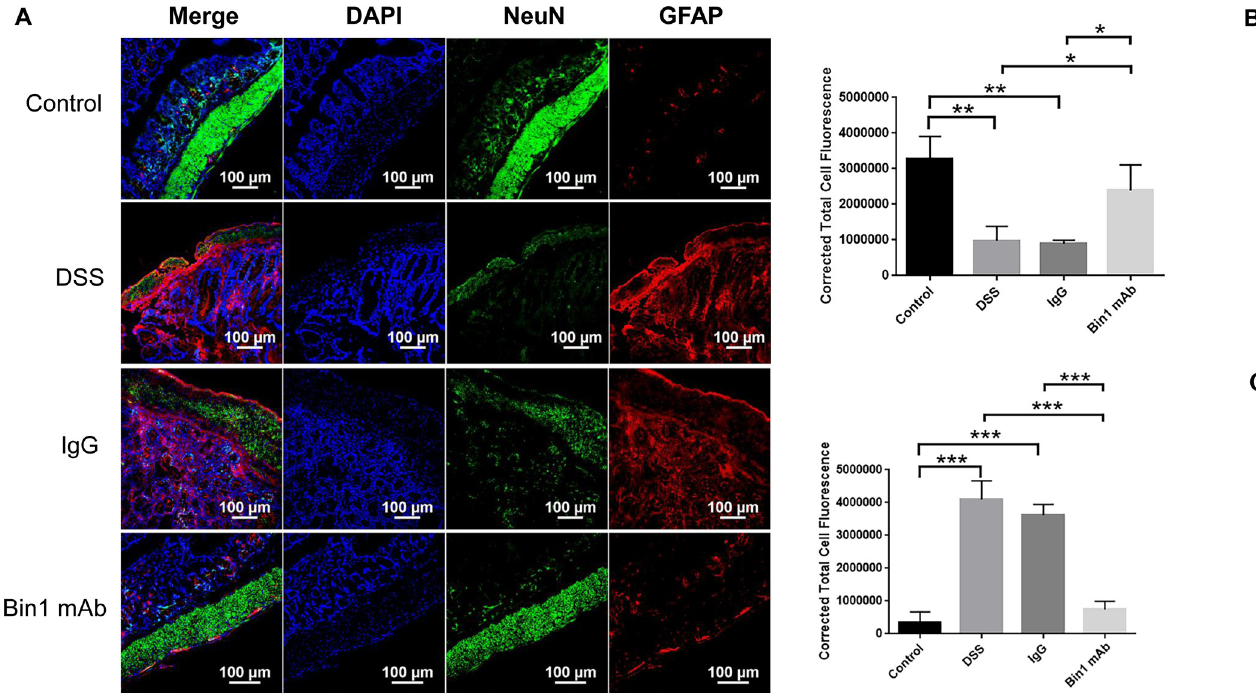
Fig 2. Bin1 mAb treatment improved NeuN expressing enteric neurons and GFAP expressing glial cells after DSS-induced colitis. Fig 2A . Effect of Bin1 mAb treatment on neuronal and glial abundance in the gut of DSS-induced colitis mice as determined by confocal microscopy. Bin1 mAb treated mice had high expression of NeuN and low expression of GFAP (n = 5). Fig 2B . Bin1 mAb treated mice had high levels of NeuN expressing neuronal cells in the muscularis of the colon as quantitated by CTCF analysis ( � P < 0.05, �� P < 0.01, as determined by t test). Control and DSS � p < 0.0060, Control and IgG � p < 0.0030, DSS and Bin1 mAb � p < 0.0414, IgG and Bin1 mAb � p < 0.0234. Fig 2C . Bin1 mAb treated mice had low levels of GFAP expressing glial cells in the colon as quantitated by CTCF analysis (CTCF analysis, n = 3 mice tissues per treatment) ( � P < 0.05, �� P < 0.01, as determined by t test). Control and DSS � p < 0.0006, Control and IgG � p < 0.0002, DSS and Bin1 mAb � p < 0.0007, IgG and Bin1 mAb � p <